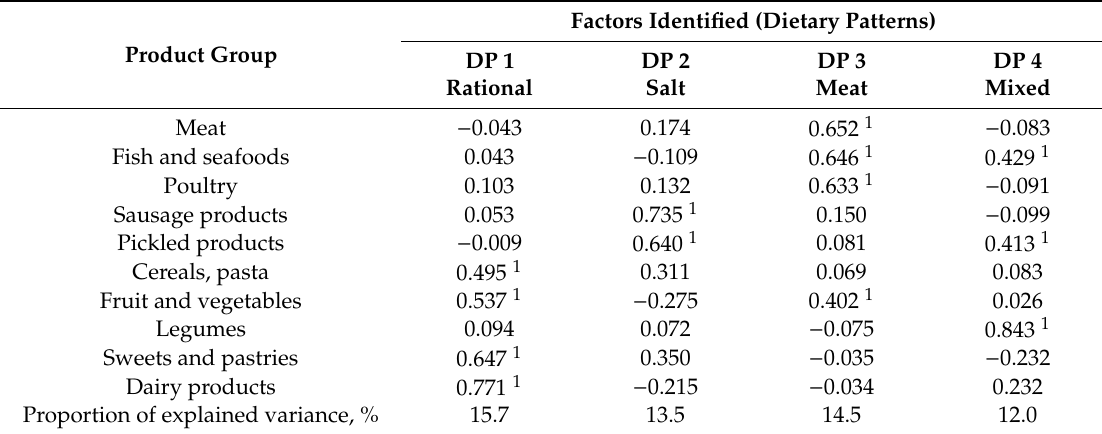
Table A1. Factor loadings of the principal dietary patterns identified (women).